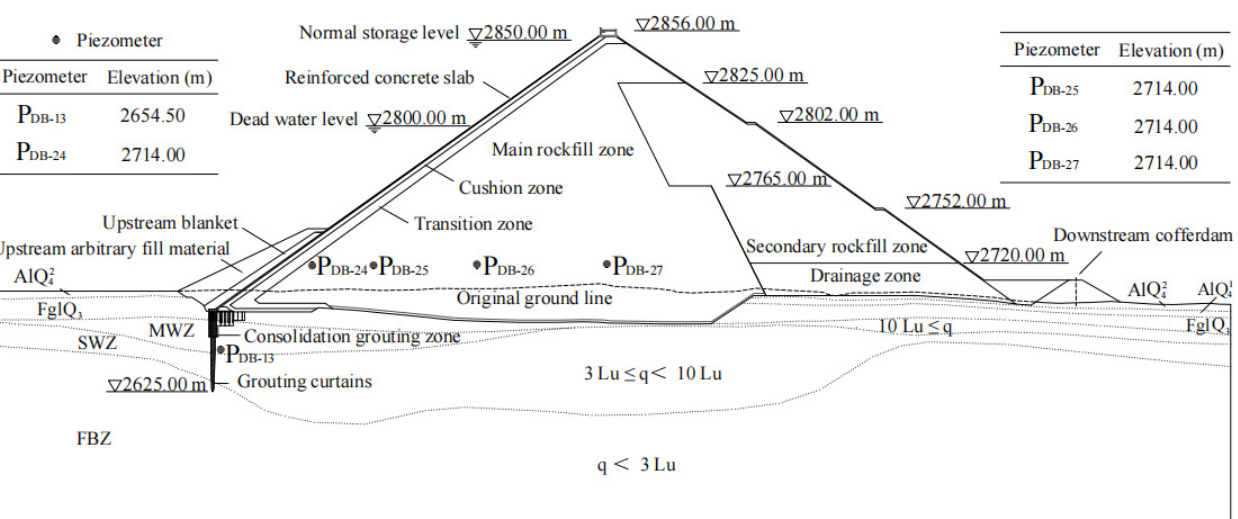
Figure 4. The location of the Kakiwa Dam.